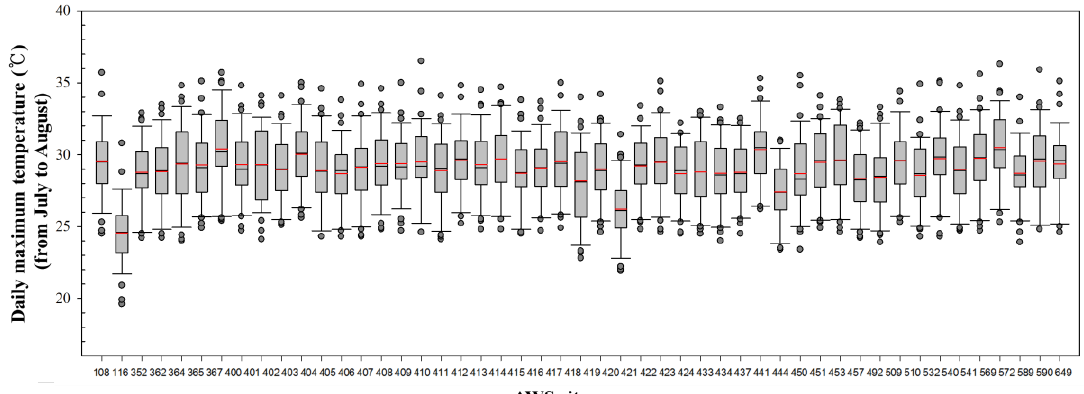
Figure 4. Distribution of the daily maximum air temperature variability of 52 Automated Weather Station (AWSs) during July to August 2015.